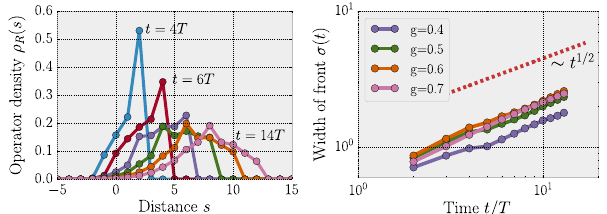
FIG. 7. Broadening of the operator wavefront with time in the kicked Ising model for parameters h ¼ 0 . 809 and T ¼ 1 . 6 . Left panel: The weight ρ ð s Þ for transverse field g ¼ 0 . 7 at times t=T ¼ 4 ; 6 ; … ; 14 . Right panel: The width of the front as defined by Eq. (30) as a function of time for different g , showing a roughly diffusive